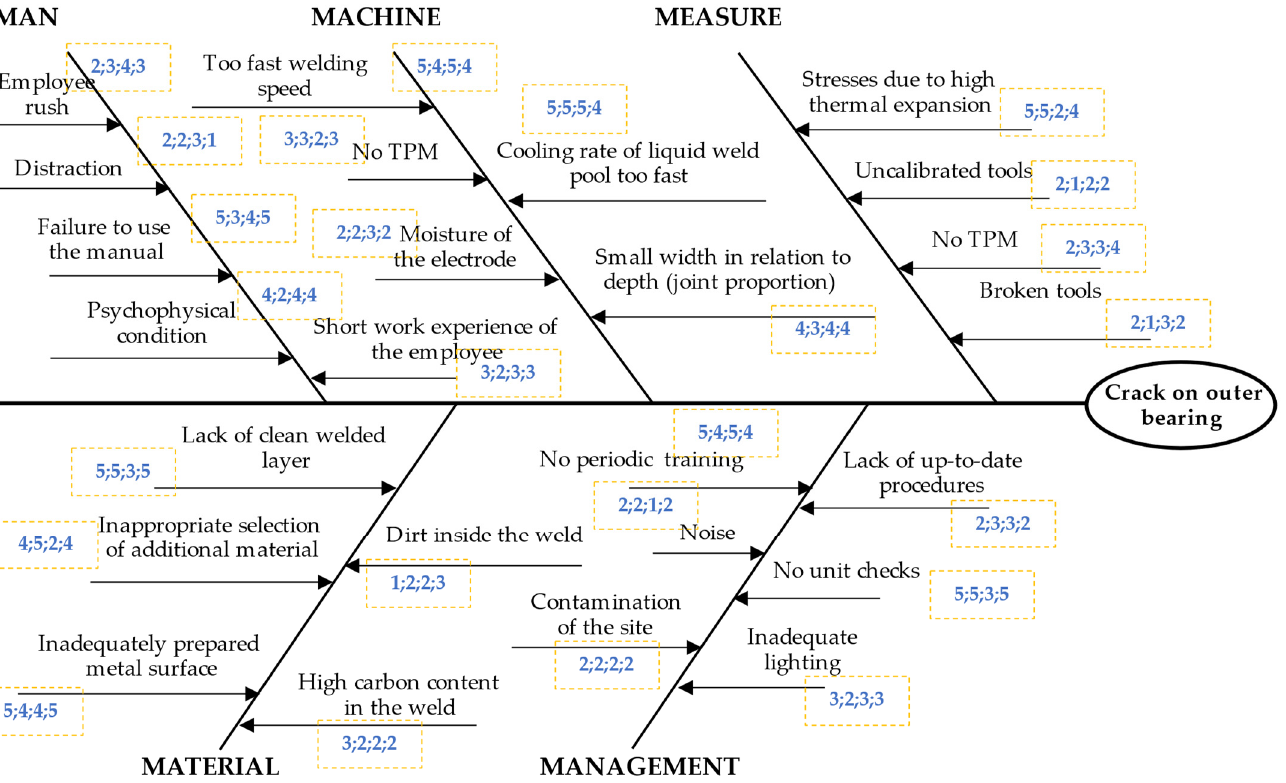
Table 2. Average weights of potential causes.